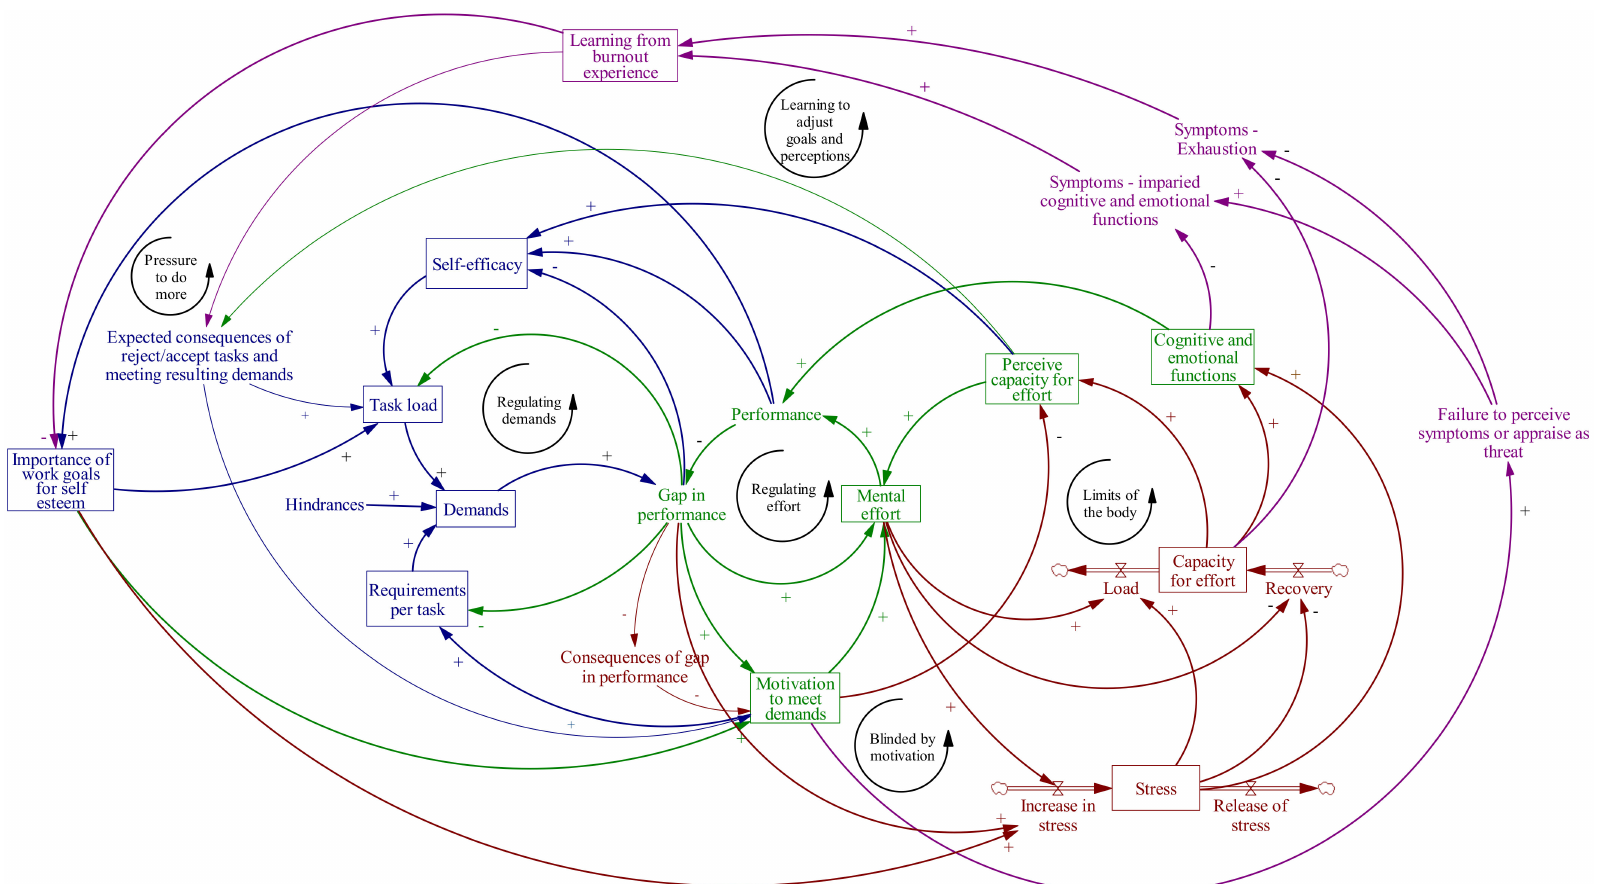
Figure 6. A system dynamics model of burnout integrating existing theoretical models, information from experts and literature, and personal burnout experiences. Colors indicate four main identified processes—regulating demands (blue), regulating e ff ort (green), impacts on body and mind (red), and burnout symptoms